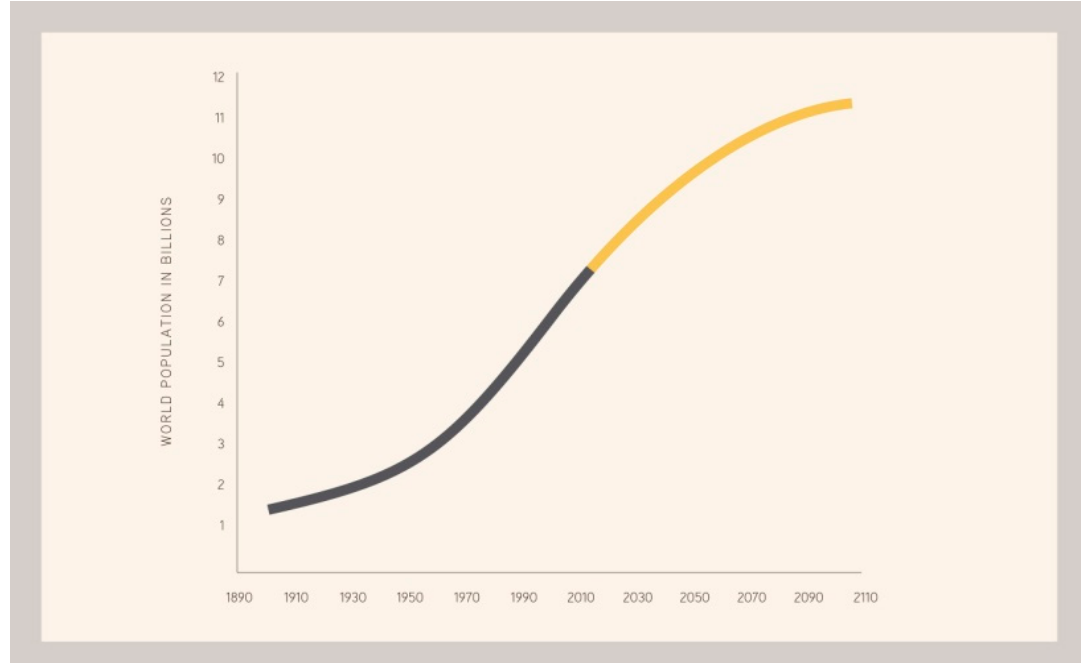
Figure 3. Projected plateau in world population growth based on median variant projections by the United Nations to 2100 [12]. This demonstrates the change from accelerating growth to decelerating growth. The inflection point of the curve was passed in the last decades of the 20th century, and humanity is currently in an age of slowing growth, one that may be very different, in terms of environmental limits and human social interactions, from the previous periods.